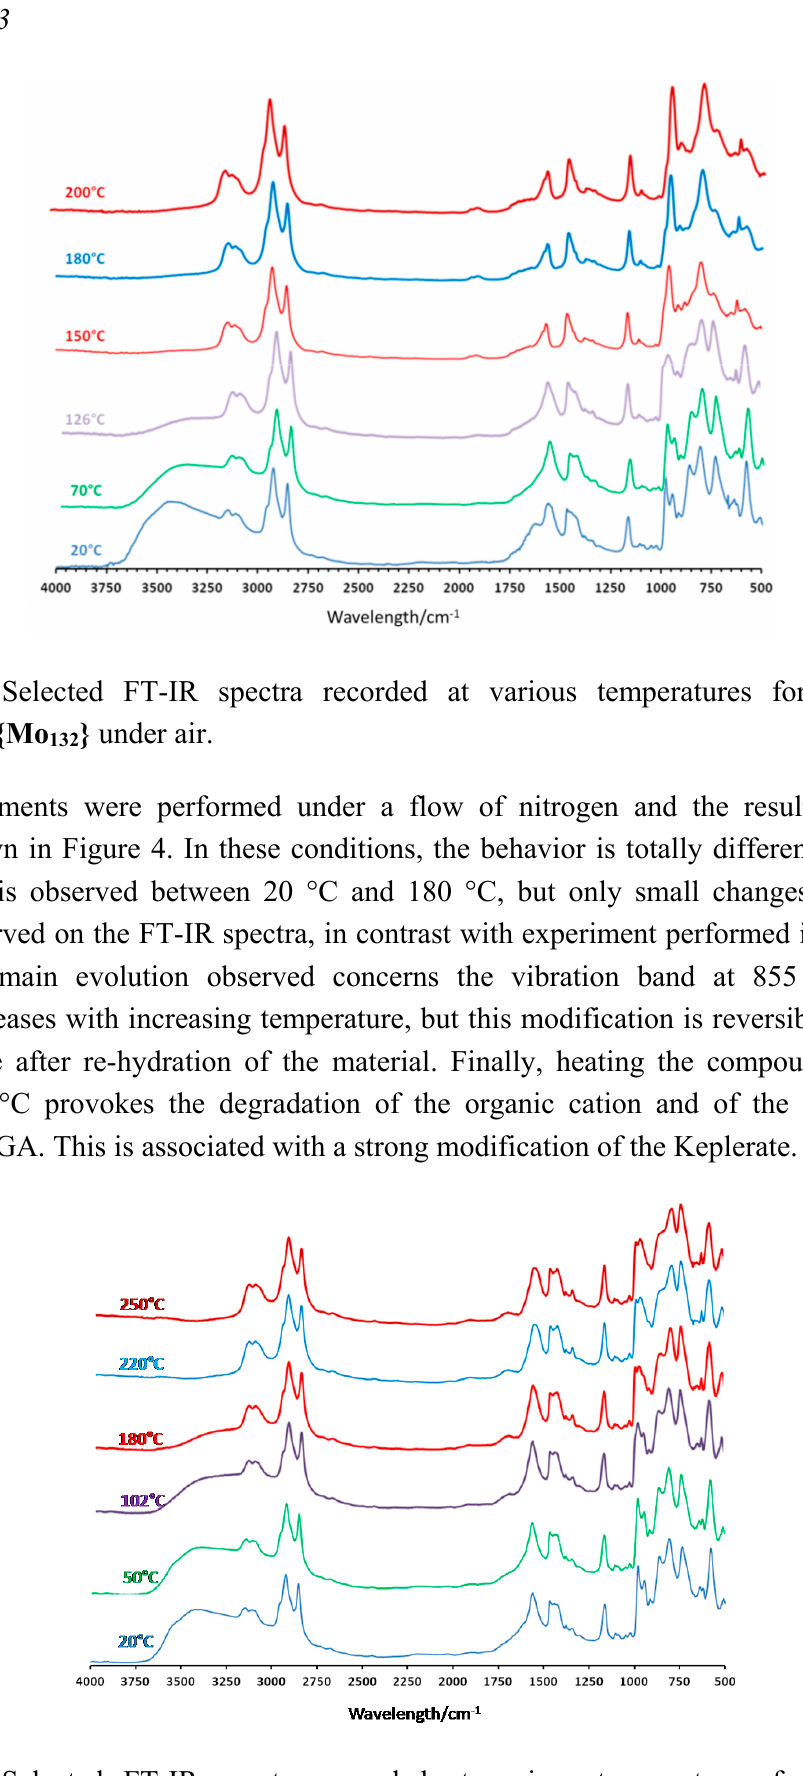
Figure 4. Selected FT-IR spectra recorded at various temperatures for compound (mimC 18 ) 37 {Mo 132 } under